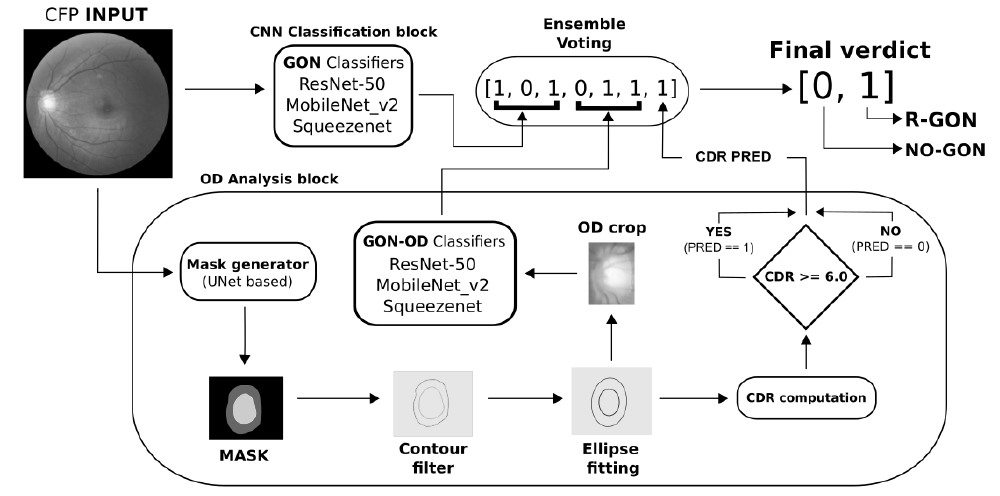
Figure 2. General scheme workflow for the proposed Multi-stage Ensemble-based CAD